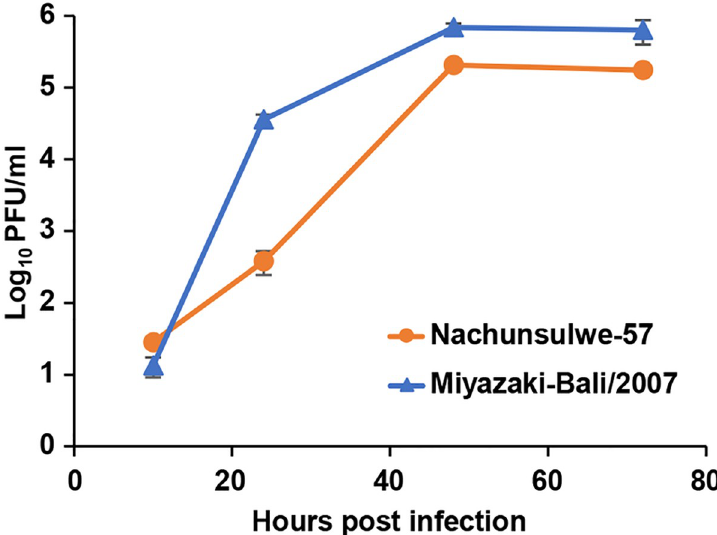
Fig 4. Growth kinetics of Nachunsulwe-57 and Miyazaki-Bali/2007 strain in cell culture. Vero E6 cells were infected with Nachunsulwe-57 or Miyazaki-Bali/2007 at 0.01 MOI. The supernatants were harvested at 10, 24, 48, and 72 hpi, and viral titers were determined by plaque assay using Vero E6 cells. Each value represents mean ± SEM of the results of three independent experiments.